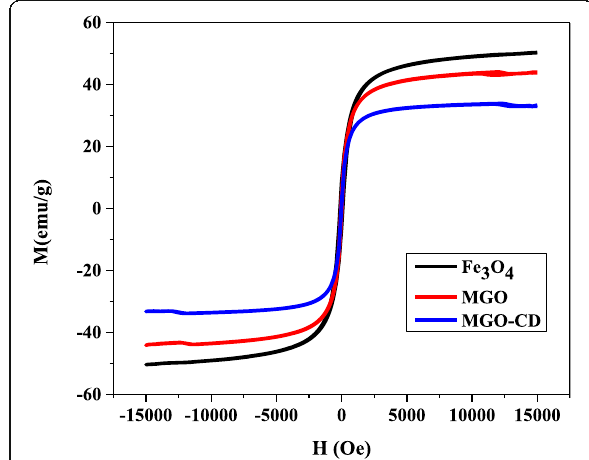
Fig. 7 Magnetization hysteresis loops of Fe 3 O 4 , MGO, and